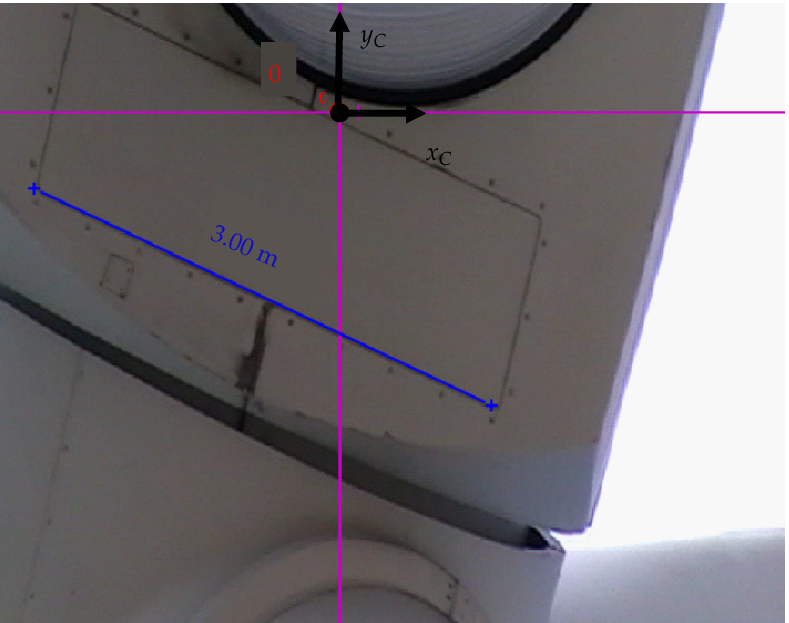
Figure 5. The origin and coordinate system (black) are defined. The length is calibrated (blue), and the point to be tracked is defined